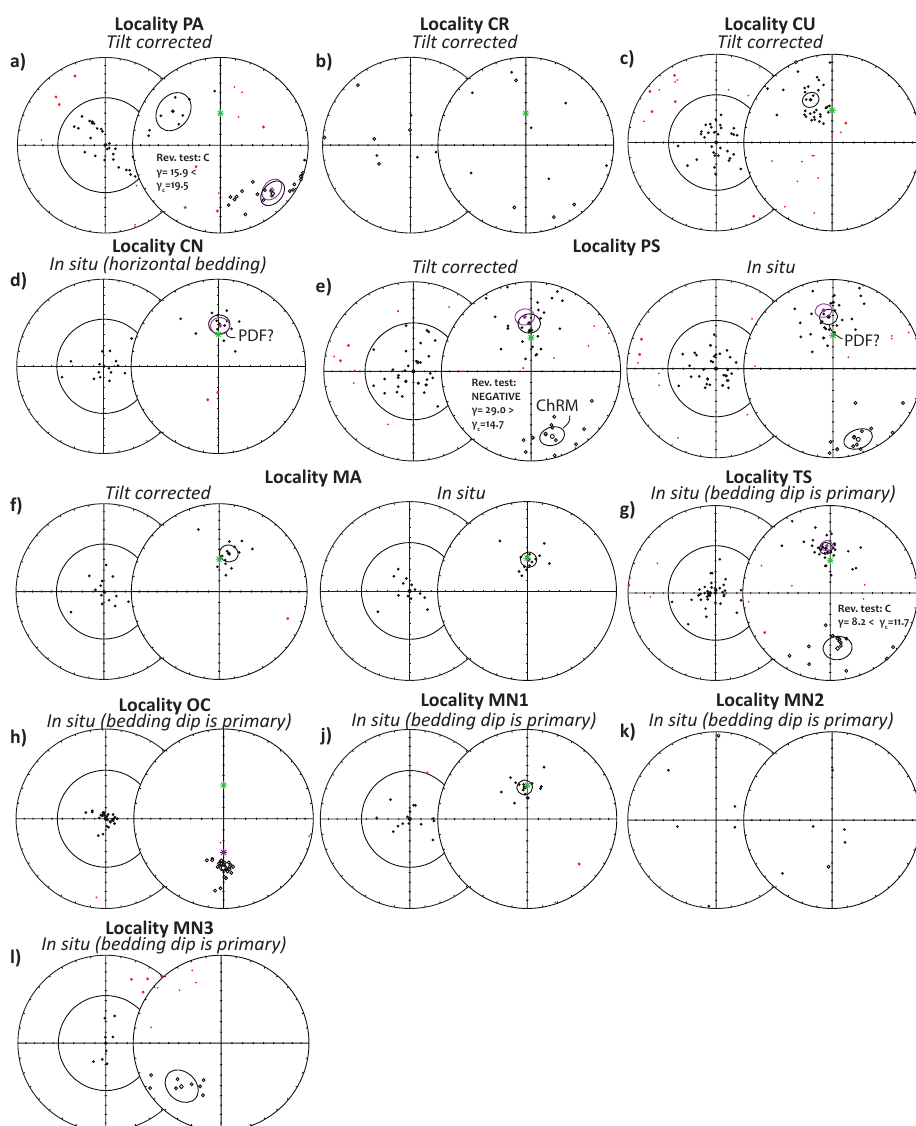
Figure 5 Figure 5. Equal area projections of the VGP (left) and ChRM directions (right) of all sites in both in situ and tilt-corrected coordinates. Open (closed) symbols correspond to the projection on the upper (lower) hemisphere. Large dots in the ChRM plots indicate the mean direction and relative cone of confidence ( α 95). Red (small) dots indicate the individual directions rejected after applying a 45 ◦ cutoff. Green asterisk ( ∗ ) indicates the present-day geocentric axial dipole (GAD) field direction at the sampled location. Sites TS, OC, and MN were sampled in sediments with a primary bedding attitudes, and should be considered in in situ